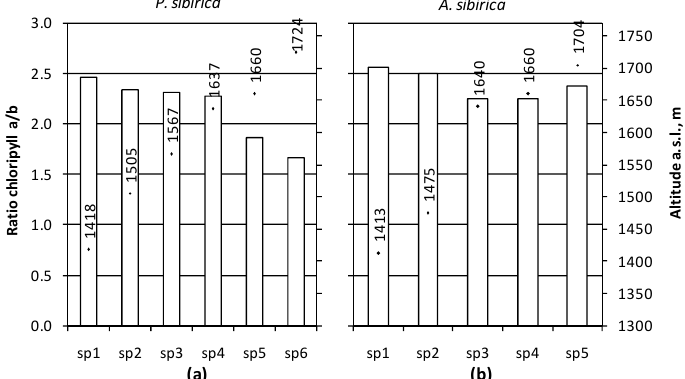
Figure 3. Change of ratio chlorophyll/carotenoids (white bars) along the study slope: ( a ) P. sibirica ; ( b ) A. sibirica . sp1–sp6 denote the numbers of sample points. Vertically oriented numbers are altitudes of the sample points.